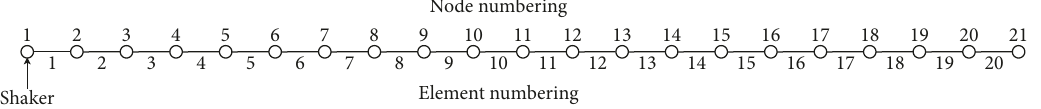
Figure 16: FEM element and node